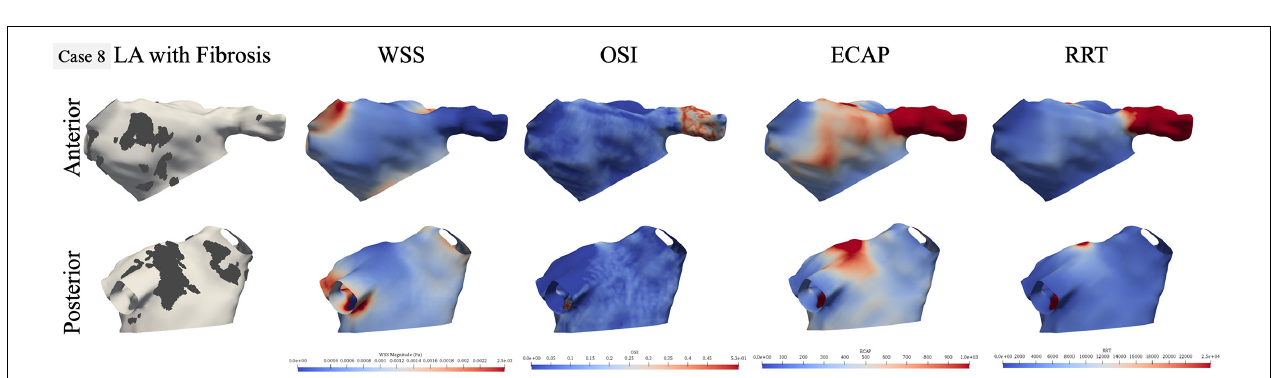
FIGURE 4 | Qualitative comparison of personalized left atrial (LA) hemodynamic results with LA fibrotic burden for the representative persistent AF case 2. Dark gray region in the left panel represents the fibrosis at the LA wall. Other panels show wall shear stress (WSS), oscillatory shear index (OSI), endothelial cell activation potential (ECAP), and relative residence time (RRT) contours, respectively: blue color represents low value, and red color represents high value.